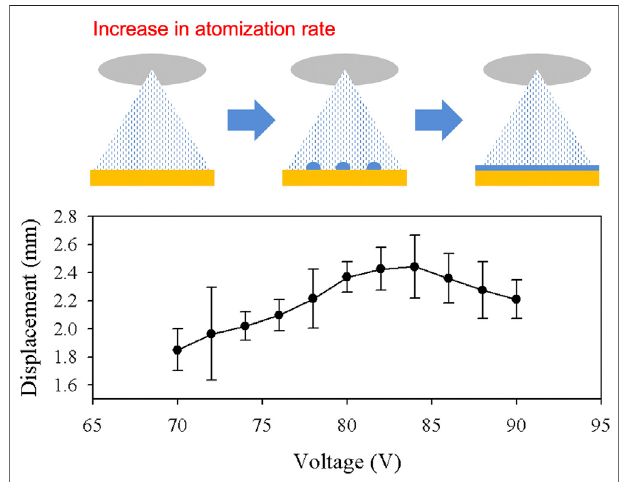
FIGURE 8 | The displacement of the top layer after 30 s of actuation is shown in the plot. Higher voltage applied to the atomizer resulted in higher atomizationrate.Thelargegrowthofthedropletsattheheatersurfaceslowed down the actuation